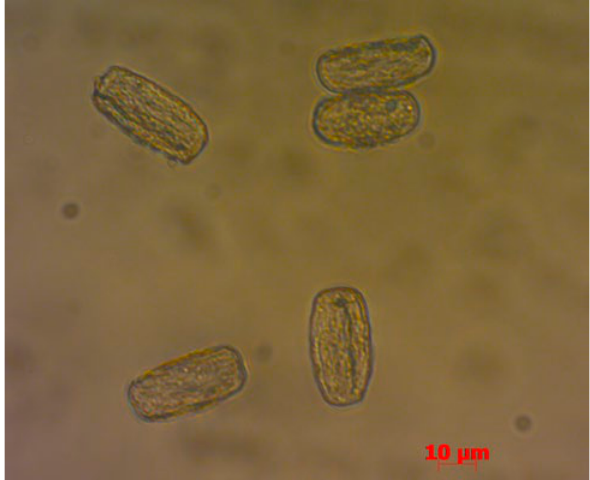
Figure 3. Conidia of Erysiphe elevata .